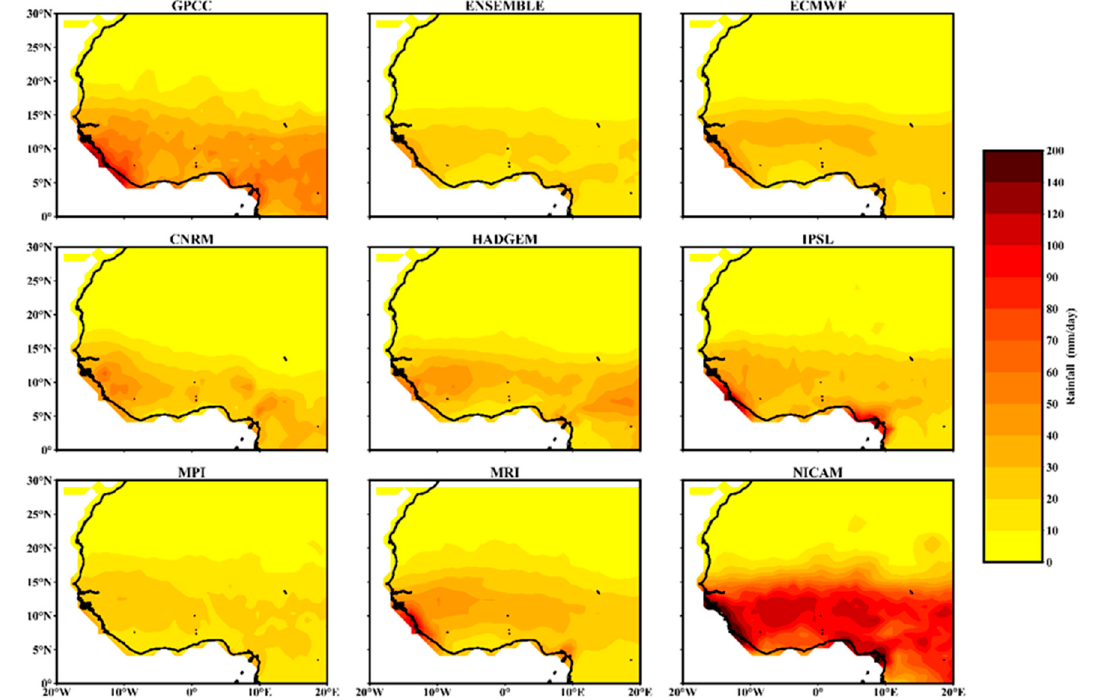
Figure 10. The spatial pattern of a 30-year return level of extreme events among the GCMs and the GPCC observation data of precipitation over the June to September period between 1985–2014. Table 3. Return level percentage grid change between the observation and GCMs. GCM Positive Negative No Change